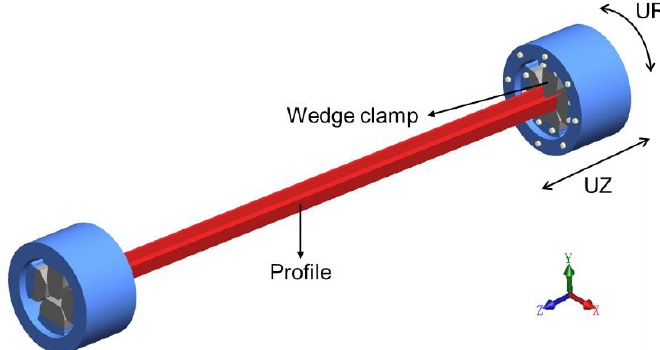
Figure 10. The hot straightening equipment model of the profile.